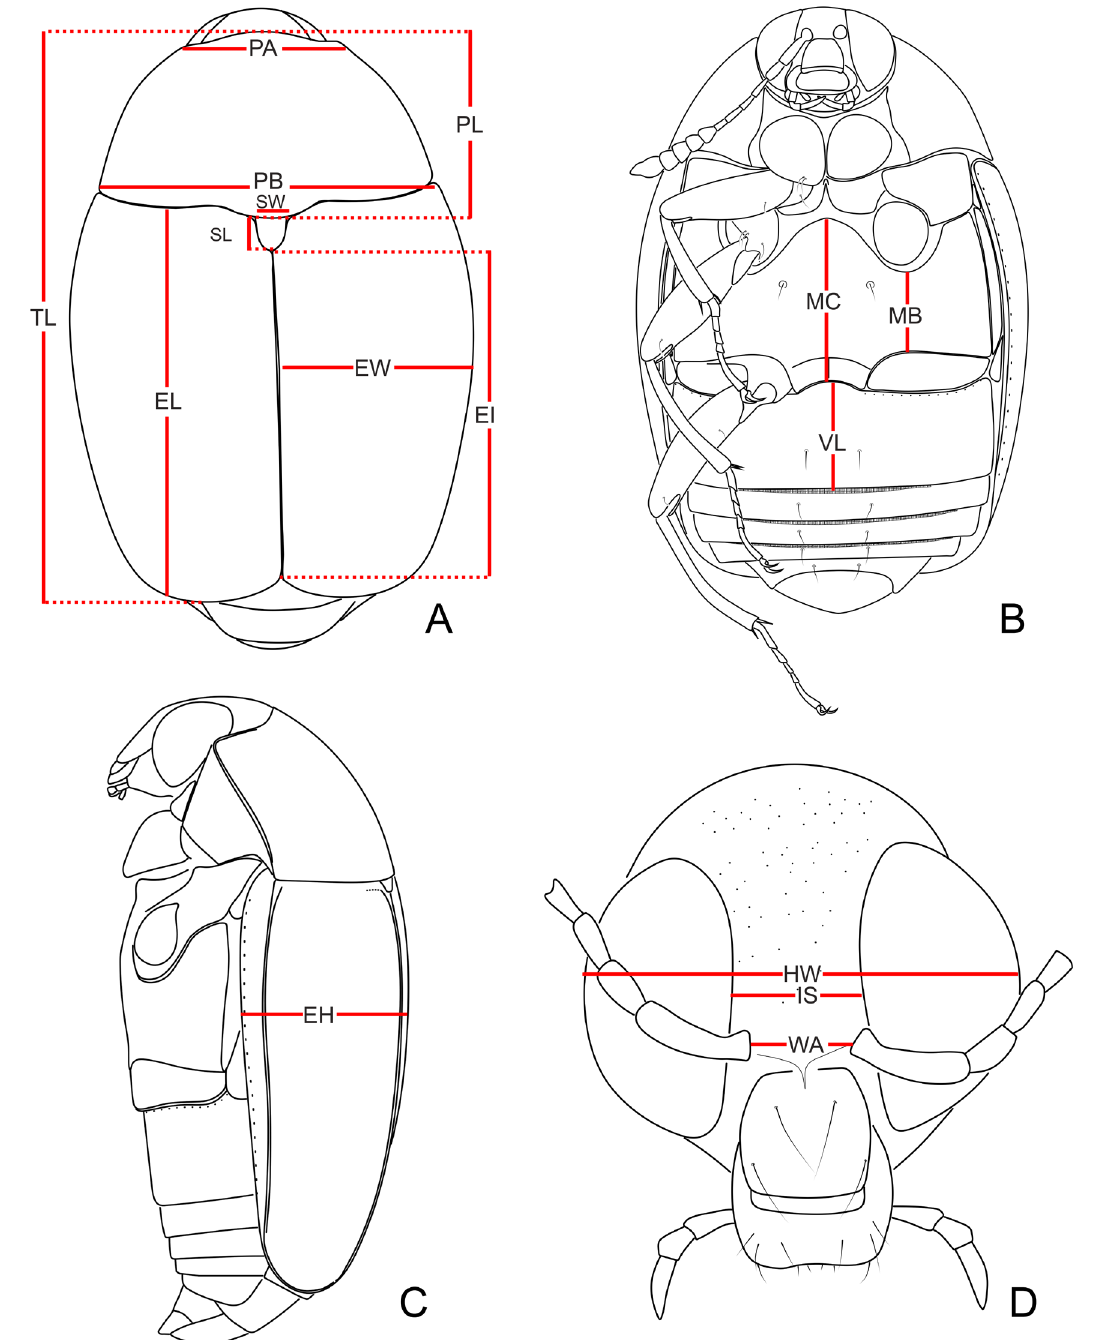
Fig. 1. Cyparium collare Pic, 1920. Measurements taken. A . Dorsal view. B . Ventral view. C . Lateral view. D . Head in frontal view. Abbreviations: EH = elytral height in lateral view; EI = length of the inner margins of elytra, not including the scutellar shield; EL = elytral length in the midline; EW = greatest right elytron width; HW = maximum width of the head including eyes; IS = interocular space; MB = mesothorax length between fore and middle legs; MC = mesothorax length in the midline; PA = pronotal width at the anterior margin; PB = pronotal width at the posterior margin; PL = pronotal length along the midline; SL = scutellar shield length; SW = scutellar shield width; TL = total body length, not including head and abdomen; VL = length of ventrite 1 in the midline; WA = width between